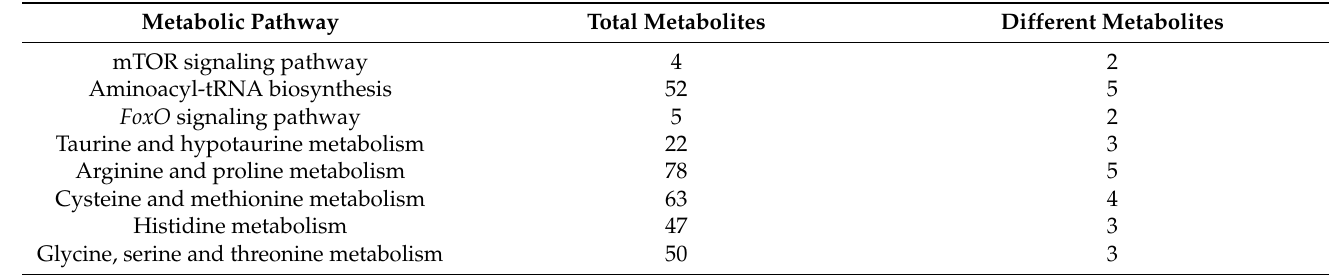
Table 9. Pathways of KEGG enrichment of different metabolites in leg muscle.